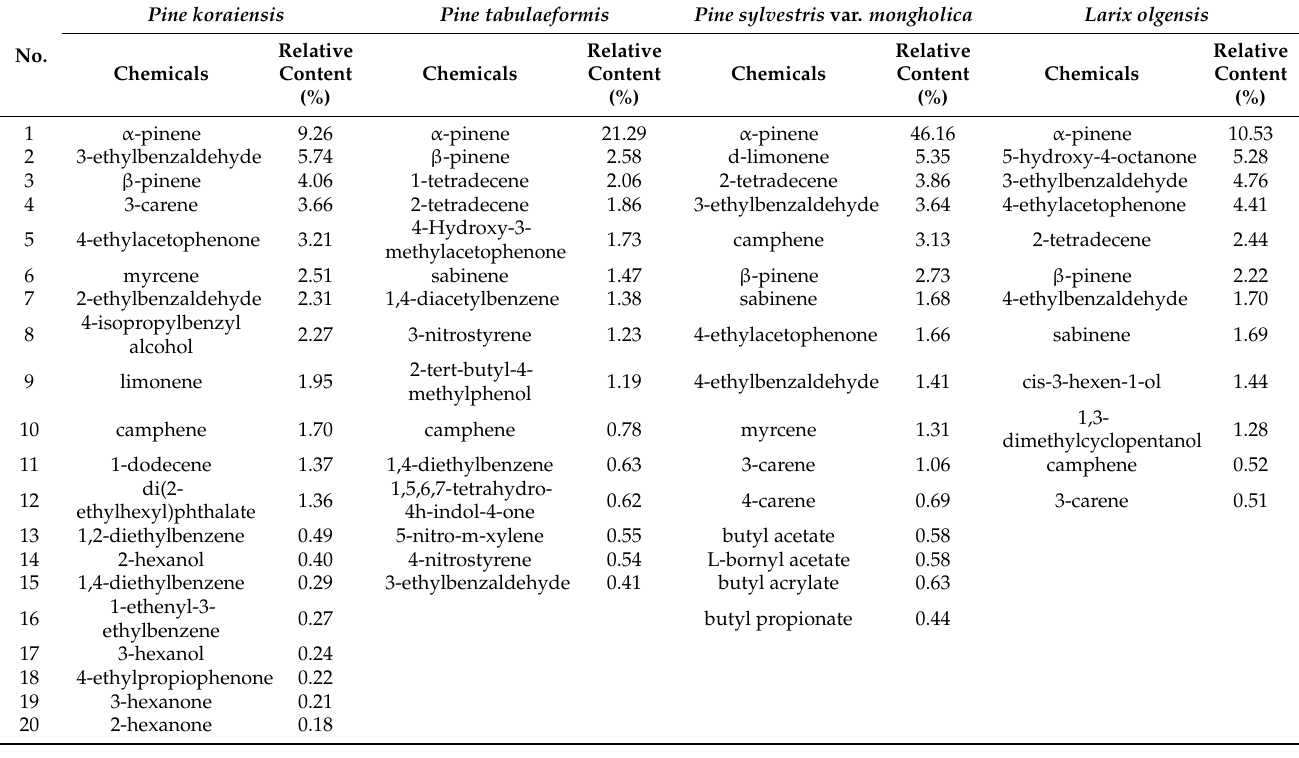
Table 1. Composition and relative contents of volatile compounds of different host pine trees.